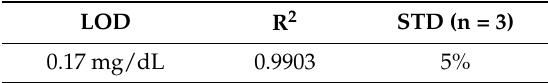
Table 1. Analytical figures of merit for the developed RGB